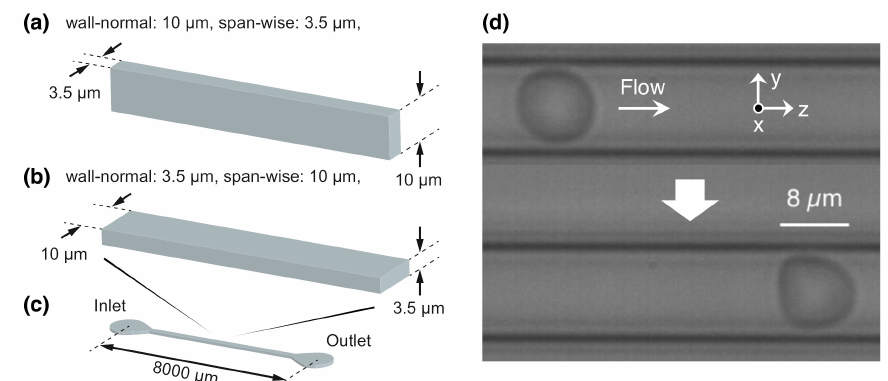
Figure A1. Detailed channel geometry. Magnified view of the channels with the cross-sections of ( a ) 10 µ m × 3.5 µ m and ( b ) 3.5 µ m × 10 µ m, which were used in Figure A2 and Figure A1, respectively. ( c ) Schematic view of the whole channel, whose stream-wise length was 8000 µ m. ( d ) Representative images of a flowing RBC in a microfluidic device. Flow direction is from left to right.